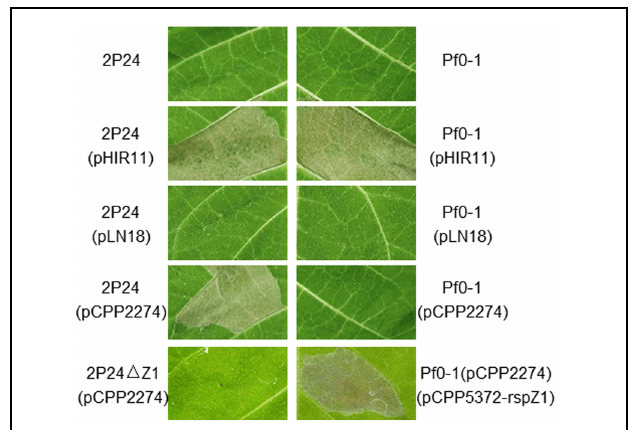
FIGURE 3 | Elicitation of the HR by P. fluorescens constitutively expressing pHIR11 and its derivatives. Leaf panels of tobacco ( N. tabacum cv. xanthi ) were infiltrated with bacterial suspensions at a concentration of 10 8 cfu/ml using a blunt-ended syringe. Cell death was evaluated and representative leaves were photographed 48 h after inoculation. The experiment was repeated three times with similar results.